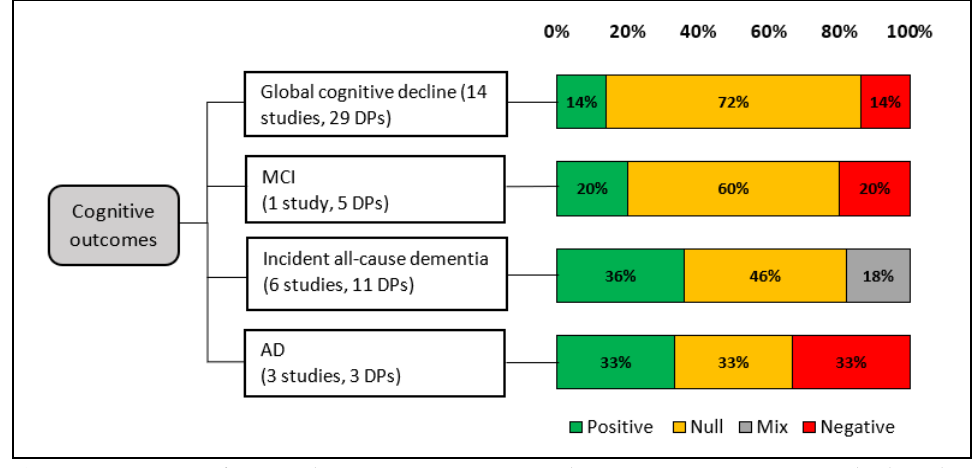
Figure 3. Overview of reported prospective associations between a -posteriori DPs and selected cog- nitive outcomes (% per number of included DPs).